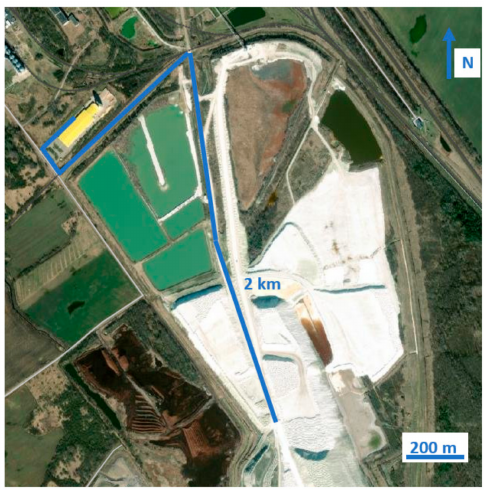
Figure 2. The proposed location of a production site near PG stocks. Figure 3 represents the input parameters for LCA calculation for all four mortar mixtures. All mortar components and their transportation are included in the material description. The mixing process of mortars are included in calculations. Allocation of MKW was assumed, as MKW is a by-product from a foam glass granule production plant. A total of 20% was allocated to MKW as by-product, and 80% of total input was allocated to foam glass granule production as it is the main process of why heat is produced, and kaolin clay is used to avoid conglomeration of foam glass granules. Metakaolin is a high value product if it is produced by purpose; up to 2.5 GJ/t of energy must be produced and a similar amount is needed to produce PC clinker (3.6–6 GJ) [30]. If no allocation would be used, the environmental impact would be in higher scale.